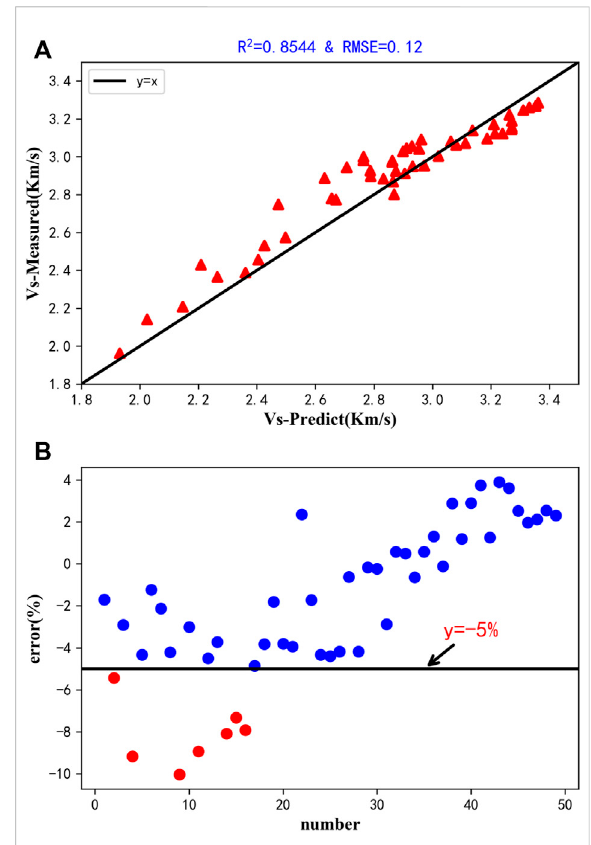
FIGURE 5 P- and S-wave velocities of samples from published literatures. (A) Han et al. (2021). (B) Li et al. (2018).